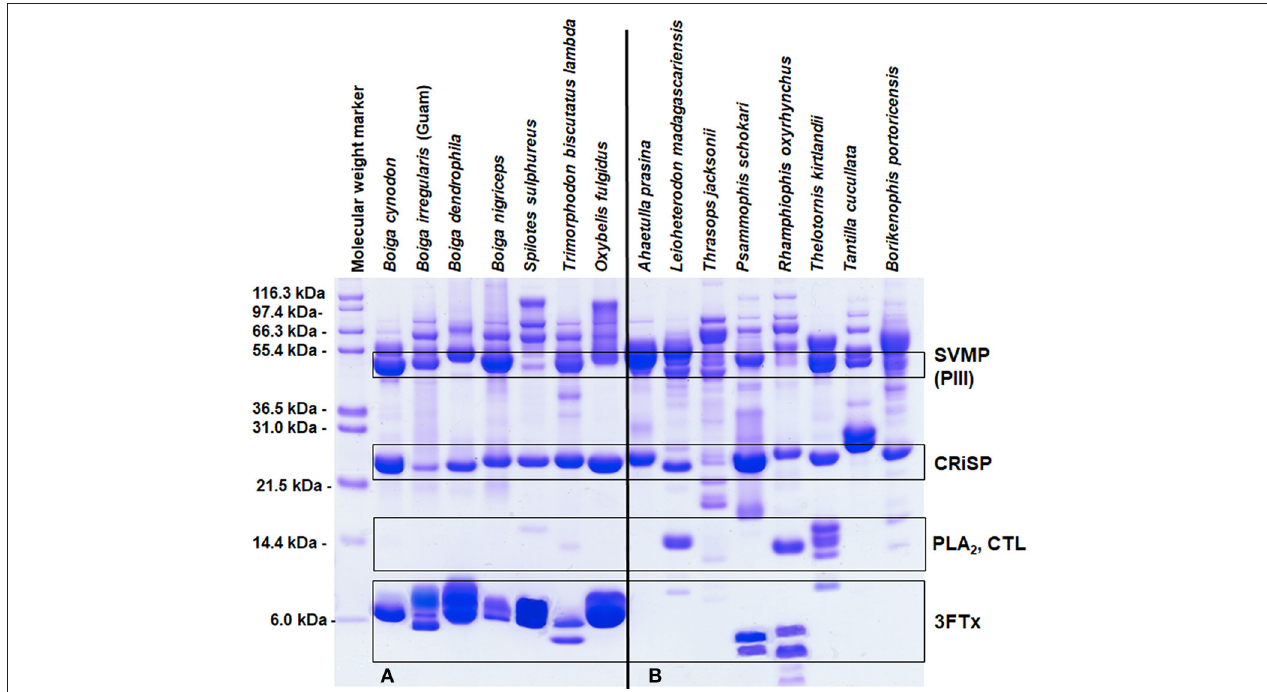
FIGURE 2 | Reduced SDS-PAGE protein profiles for various rear-fanged snake venoms. Rear-fanged snakes tend to have either three-finger toxin-dominated venoms (A) or venoms rich in metalloproteinases (B) . Molecular masses are indicated on the left, and putative venom protein identities are listed on the right. 3FTx, three-finger toxin; CRiSP, cysteine-rich secretory protein; CTL, C-type lectin; PLA 2 , phospholipase A 2 ; and SVMP (PIII), snake venom metalloproteinase type PIII. Modified from Modahl et al.